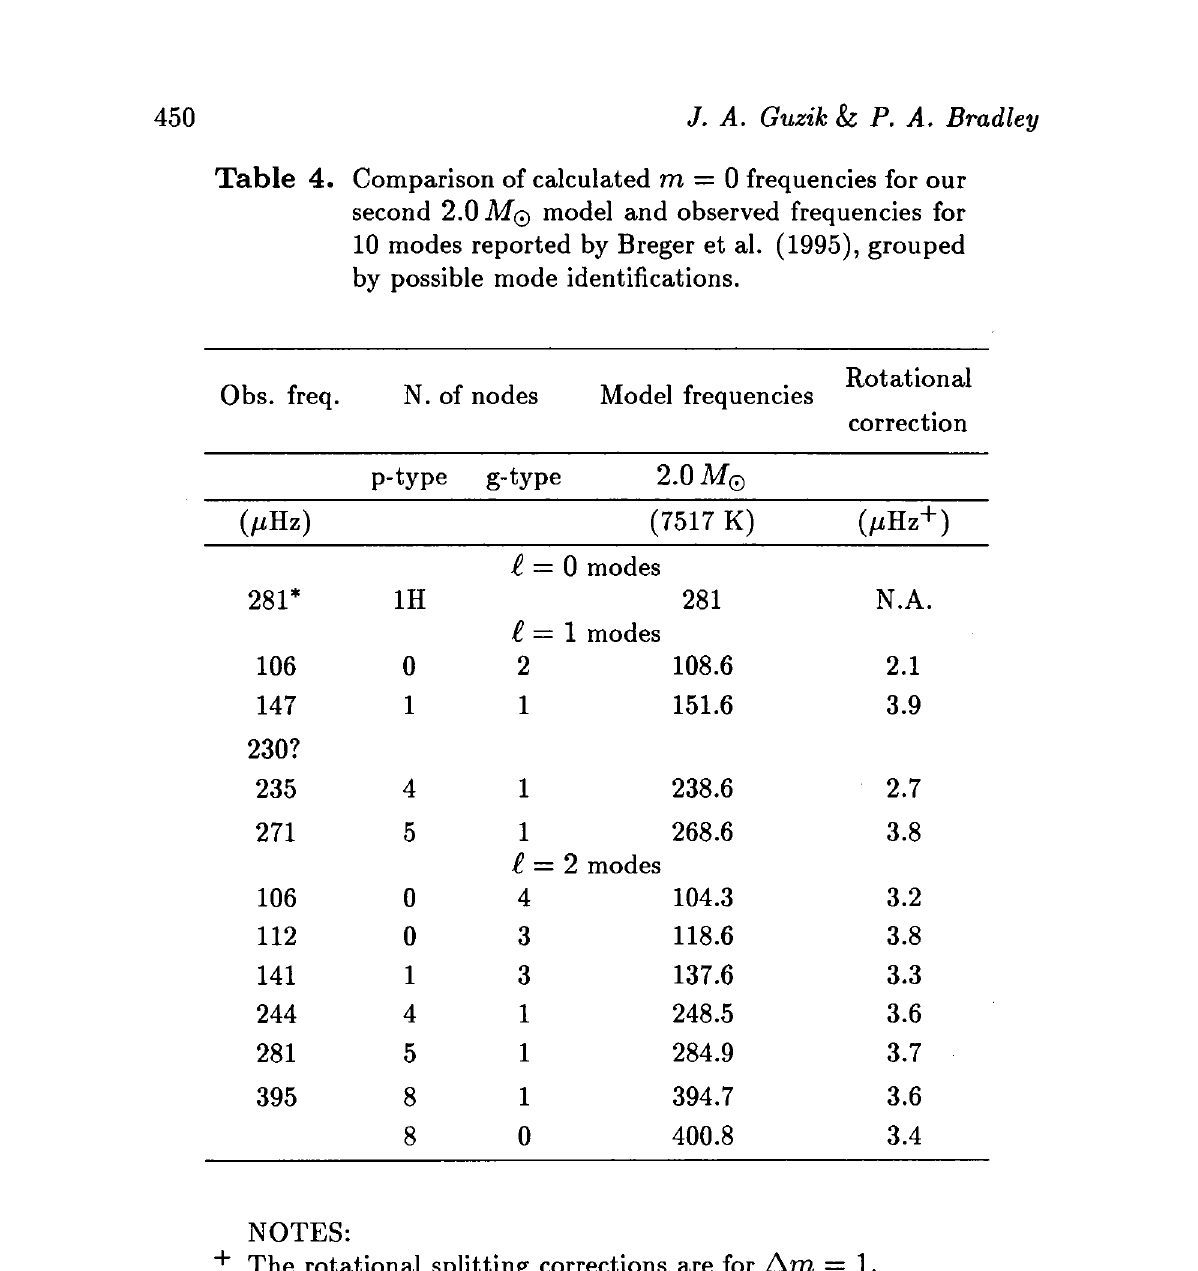
Table 4. Comparison of calculated m = 0 frequencies for our second 2.0 MQ model and observed frequencies for 10 modes reported by Breger et al. (1995), grouped by possible mode identifications.